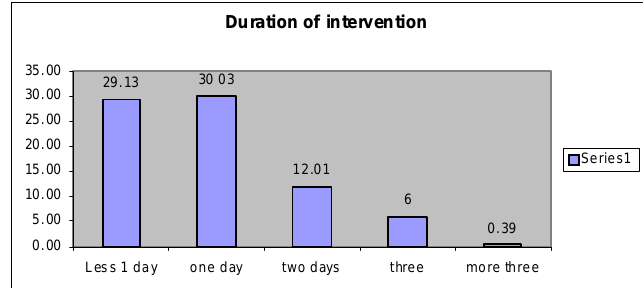
Figure 3: Duration of intervention